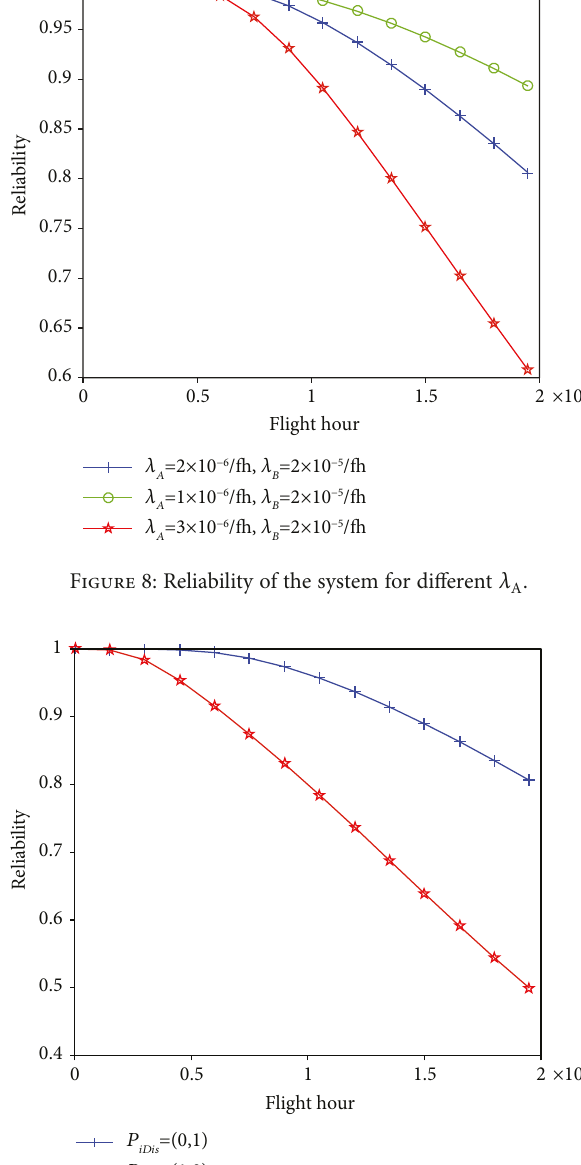
Figure 9: Reliability of the system for di ff erent P